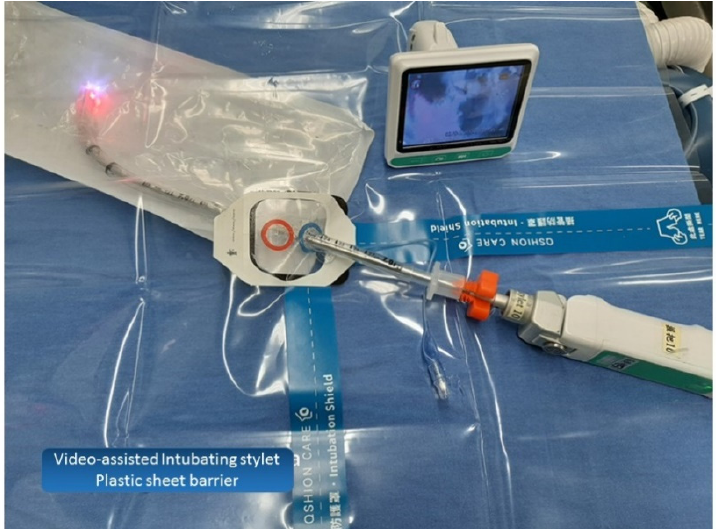
Figure 2. Preparation of the video-assisted intubating stylet, endotracheal tube, and a piece of manufactured plastic sheet. The technical note for preparation and specifications of the clear plastic sheet barrier can be found in the reference [11].